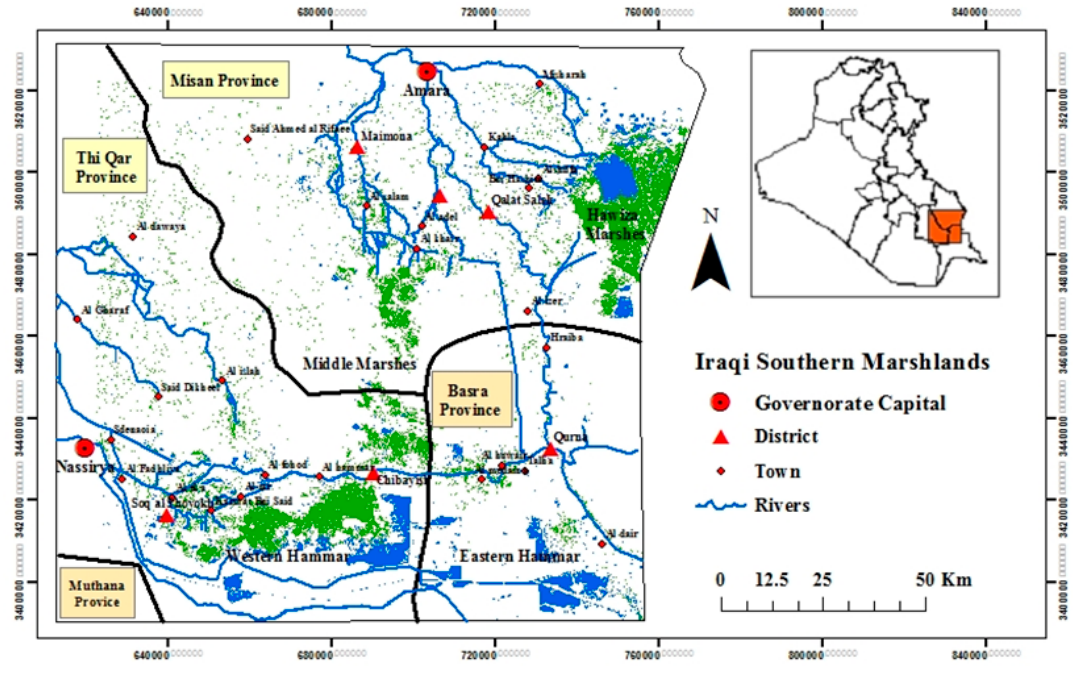
Figure 1. Marshlands in southern Iraq.